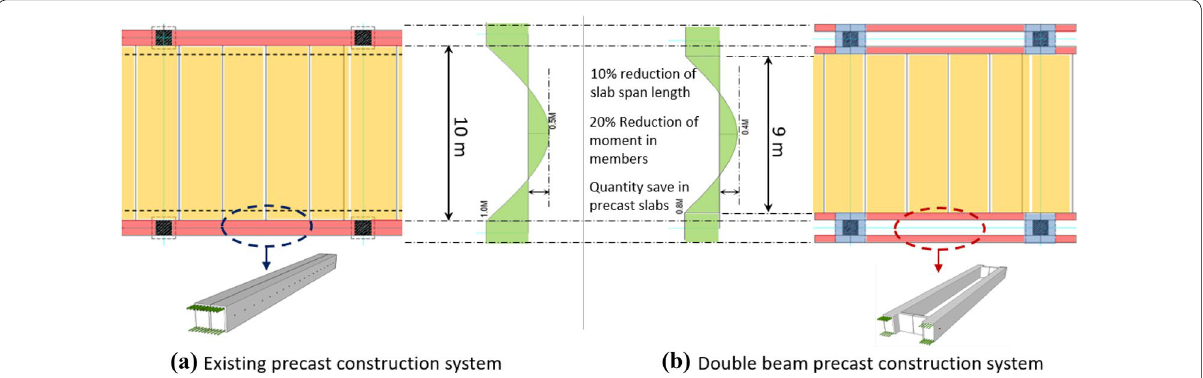
Fig. 2 Comparison of existing PC system and double‑beam PC